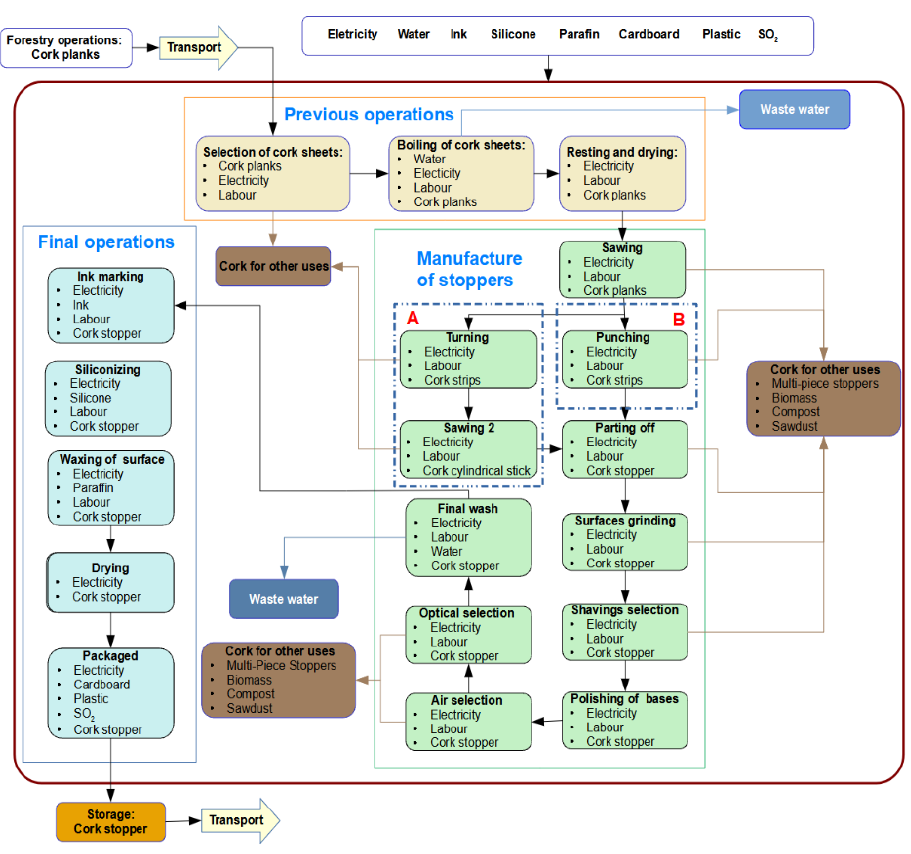
Figure 1. System boundaries.